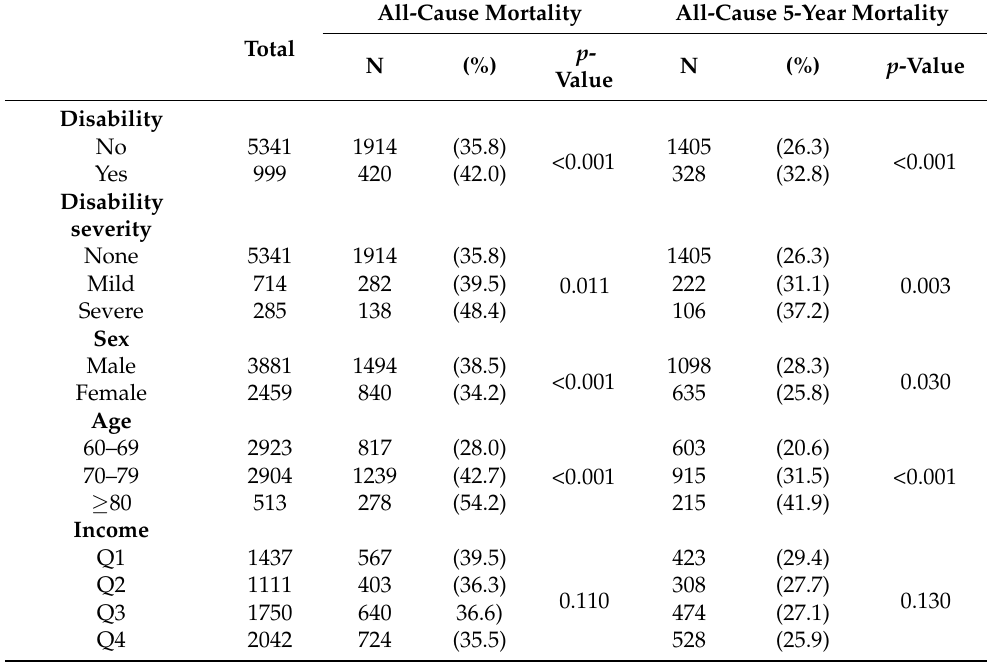
Table 1. General characteristics of the study population.